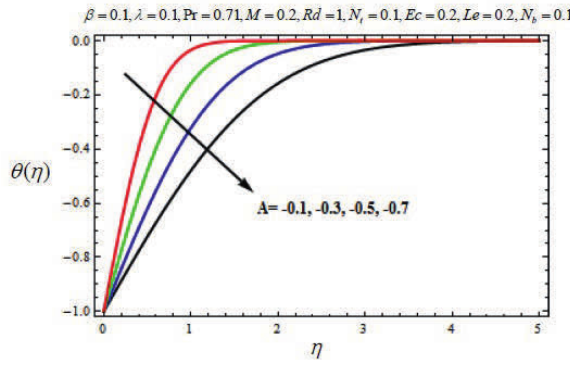
Fig. 15: Variation of temperature profile θ ( η ) with η for several val- ues of heat sink parameter A < 0 .